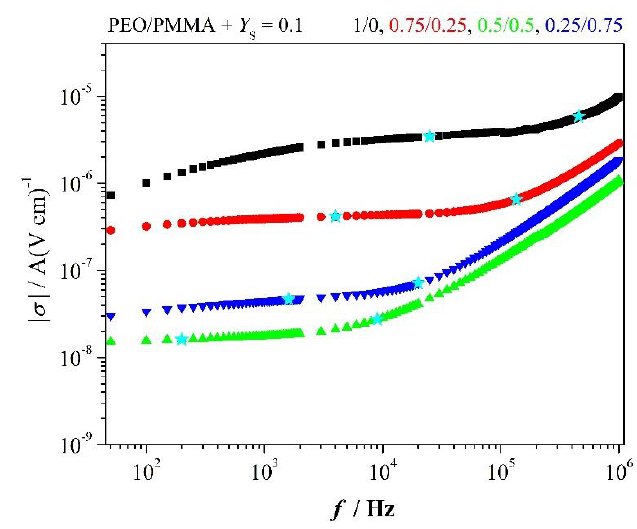
(cid:48)(cid:48) f and "Z f Figure 10. Conductivity spectra; stars indicate frequencies f Z (cid:48)(cid:48) and f Z min min max